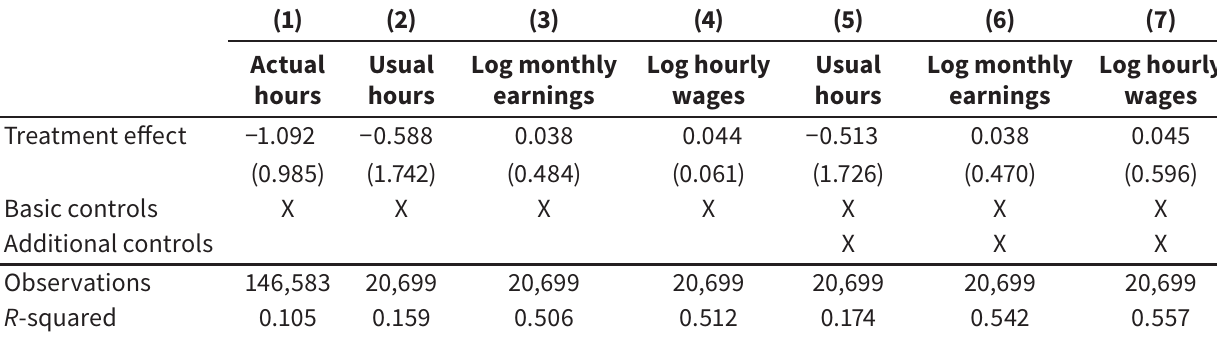
Pre-trend tests for individual-level outcomes